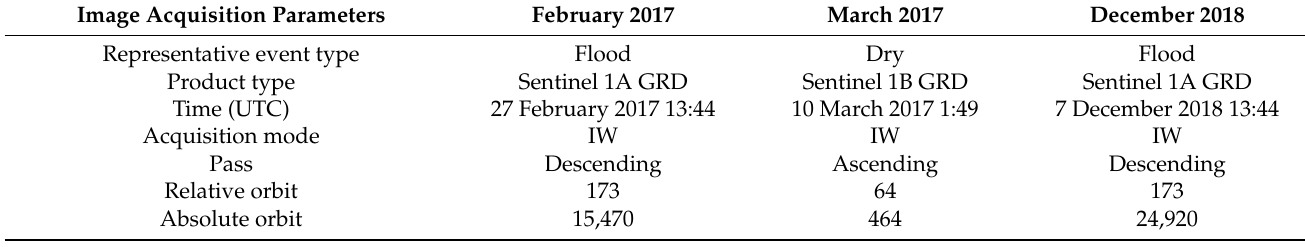
Table 1. Sentinel 1 datasets used in the present research.